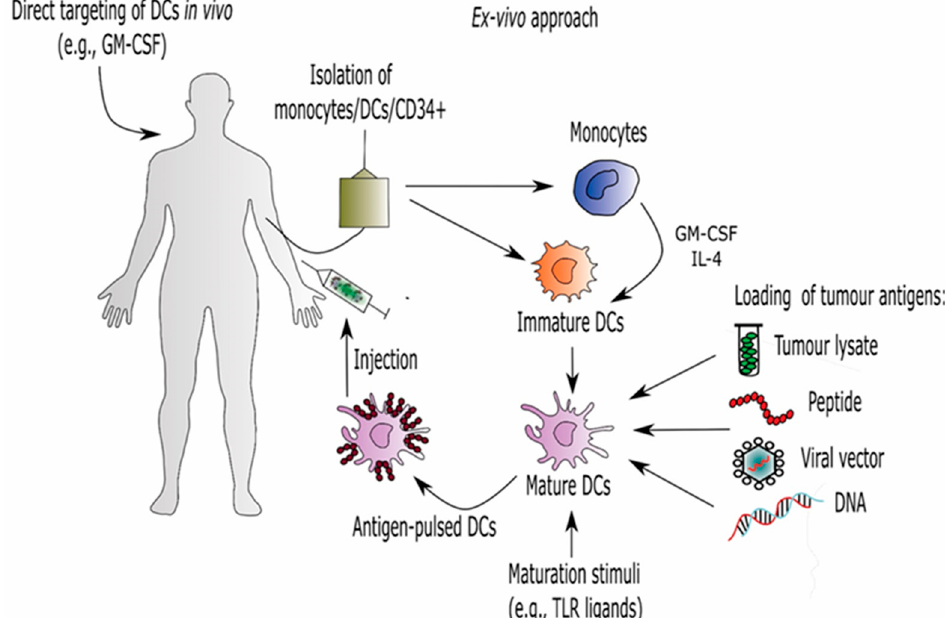
Figure 2. Dendritic cell-based immunotherapy. Approaches for generating DCs-based vaccines include direct expansion of circulating DCs, isolation of circulating DC subsets, and differentiation from monocytes or CD34+ progenitor cells. After differentiation, immature DCs are activated with different maturation stimuli and loaded with tumor antigens. Finally, prepared antigen-loaded DCs are injected to the patient.